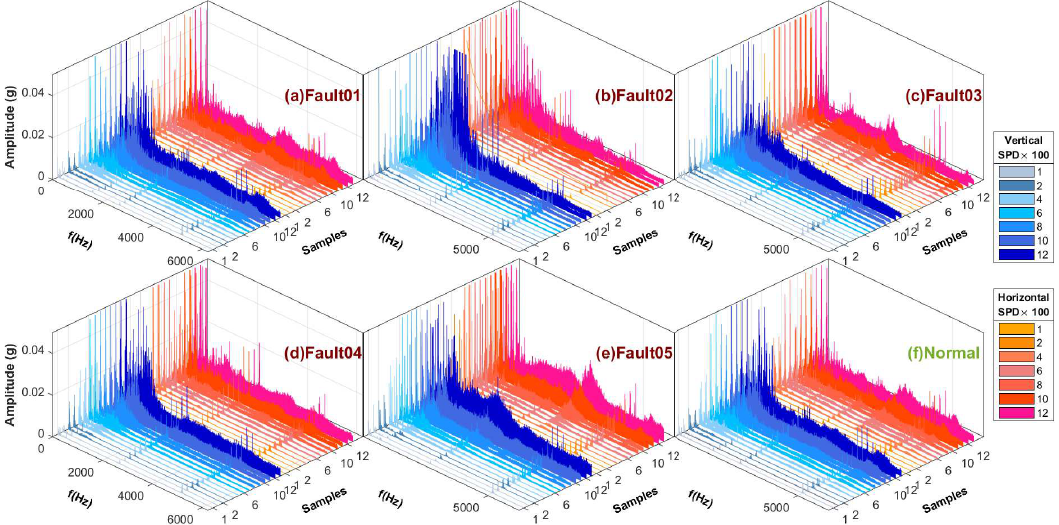
Figure 13. Spectrum comparison of six data sources.